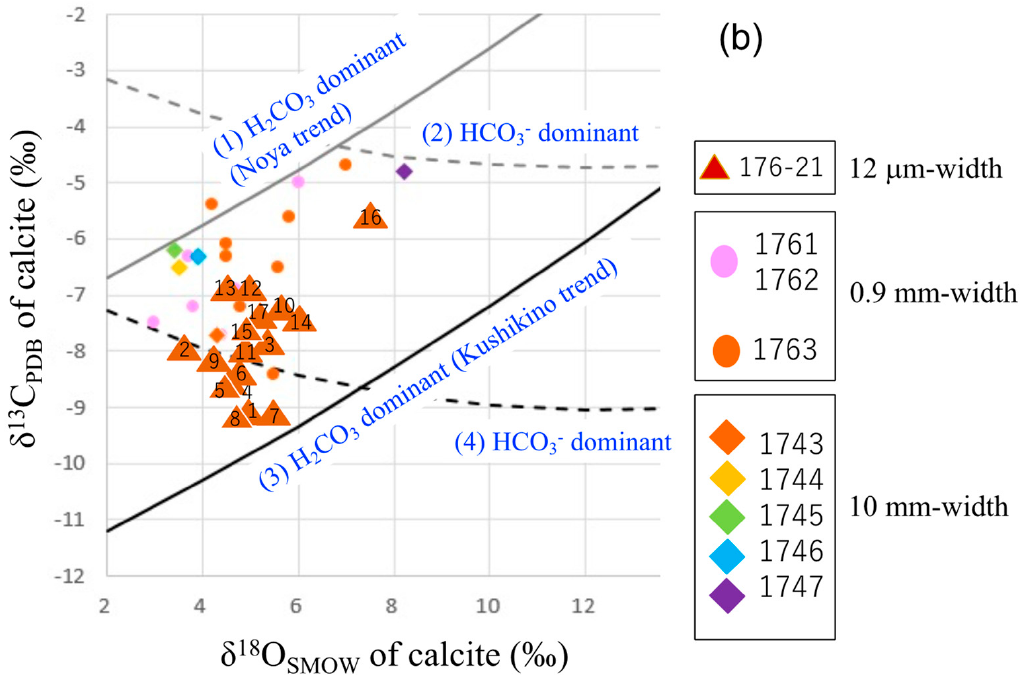
Figure 9. The results of microanalysis. The δ 13 C and δ 18 O values of calcite (micro-scale samples obtained by a microtome; Table 4) are superimposed in Figure 8. The number with the symbol represents the growth order. The equilibrium fractionation trends of calcite for the Noya and Kushikino deposits are also shown. ( a ) The 12 µ m-width samples (176-20-1 to 176-20-12) were taken from the 176-20 section. ( b ) The 12 µ m-width samples (176-21-1 to 176-21-17) were taken from the 176-21 section.